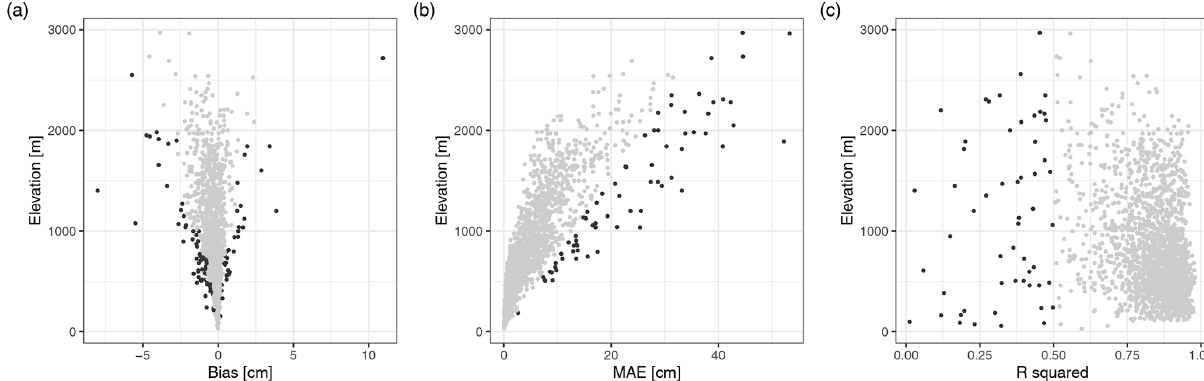
Figure A4. Metrics for spatial consistency: (a) bias, (b) mean absolute error (MAE), and (c) R 2 (squared correlation). Metrics were derived from statistical simulations of the monthly series from December to February using spatial neighbours. Black points indicate stations which were further analysed with manual